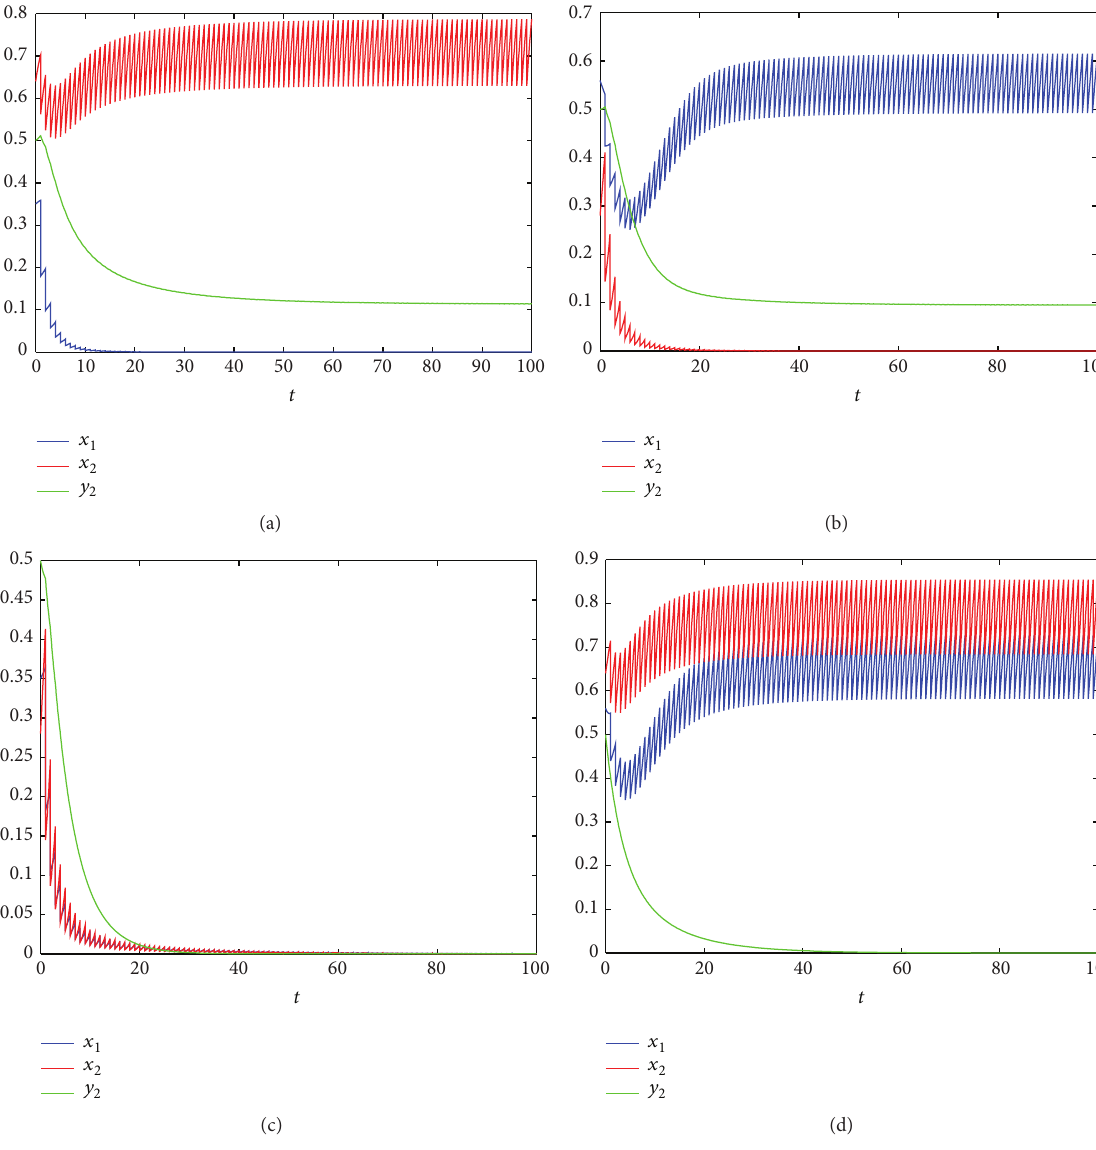
𝜆 𝛽 𝑓 (𝜂 )) < 𝑑 2 2 2 2